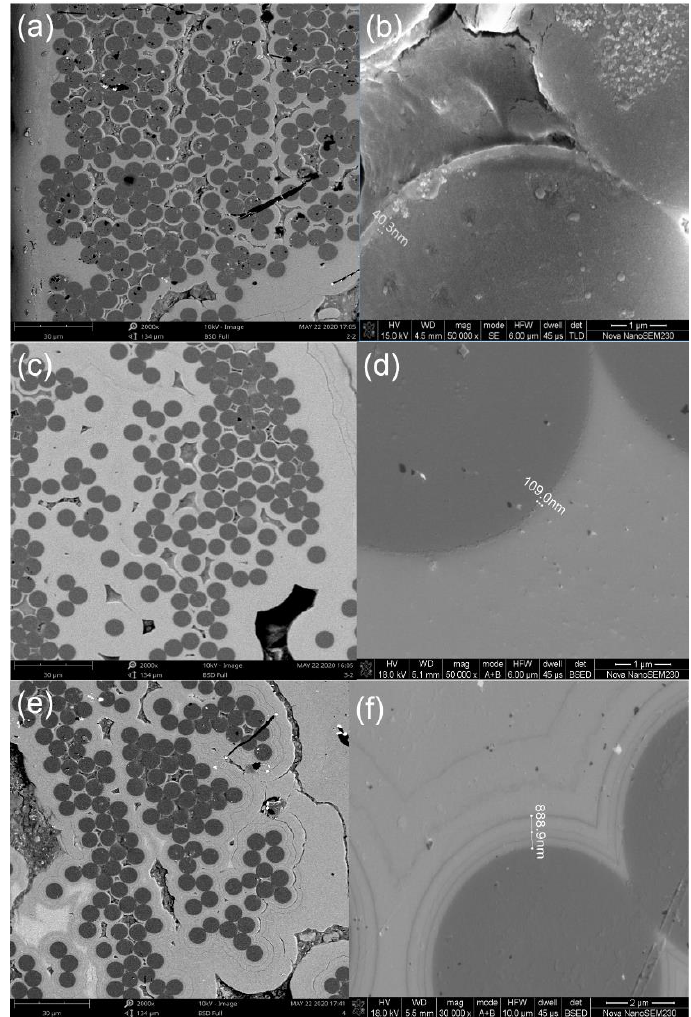
Figure 2. C/SiC minicomposite with different interphases: ( a ) Type I interphase; ( b ) the interphase thickness of Type I interphase; ( c ) Type II interphase; ( d ) the interphase thickness of Type II interphase; ( e ) Type III interphase; and ( f ) the interphase thickness of Type III interphase. Table 2. The detailed processing parameters of the samples in each group.